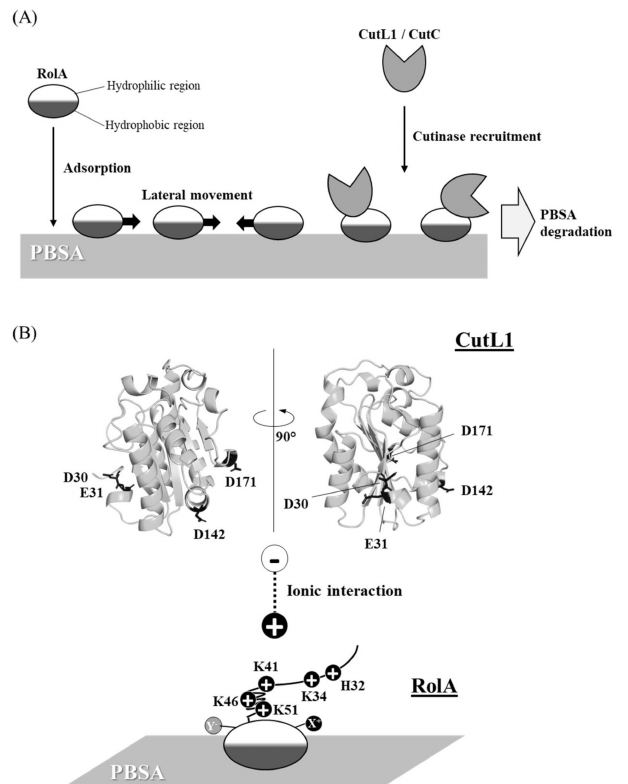
Figure 3. Schematic model of PBSA–RolA–CutL1 interaction. ( A ) Adsorption, lateral mobility, and cutinase recruitment by RolA on the PBSA surface (based on [8]). ( B ) Mechanism of the interaction between RolA and CutL1 (adapted from